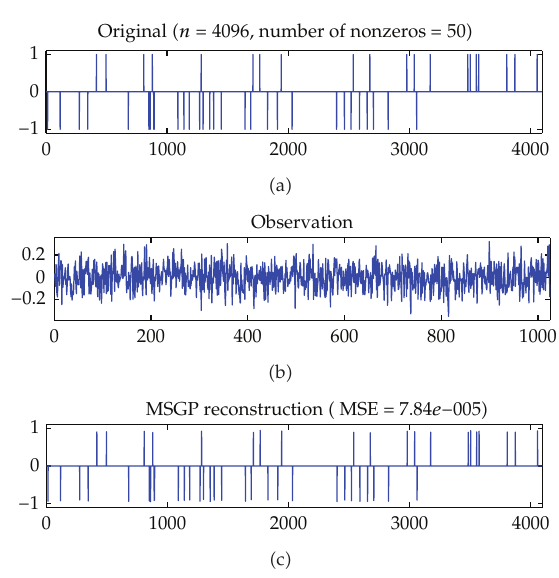
Figure 1: From top to bottom: original signal, observation, and reconstruction obtained by